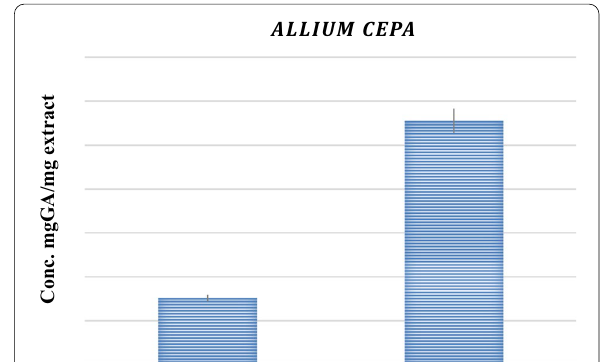
Fig. 1 Total phenolic concentration of the A. cepa